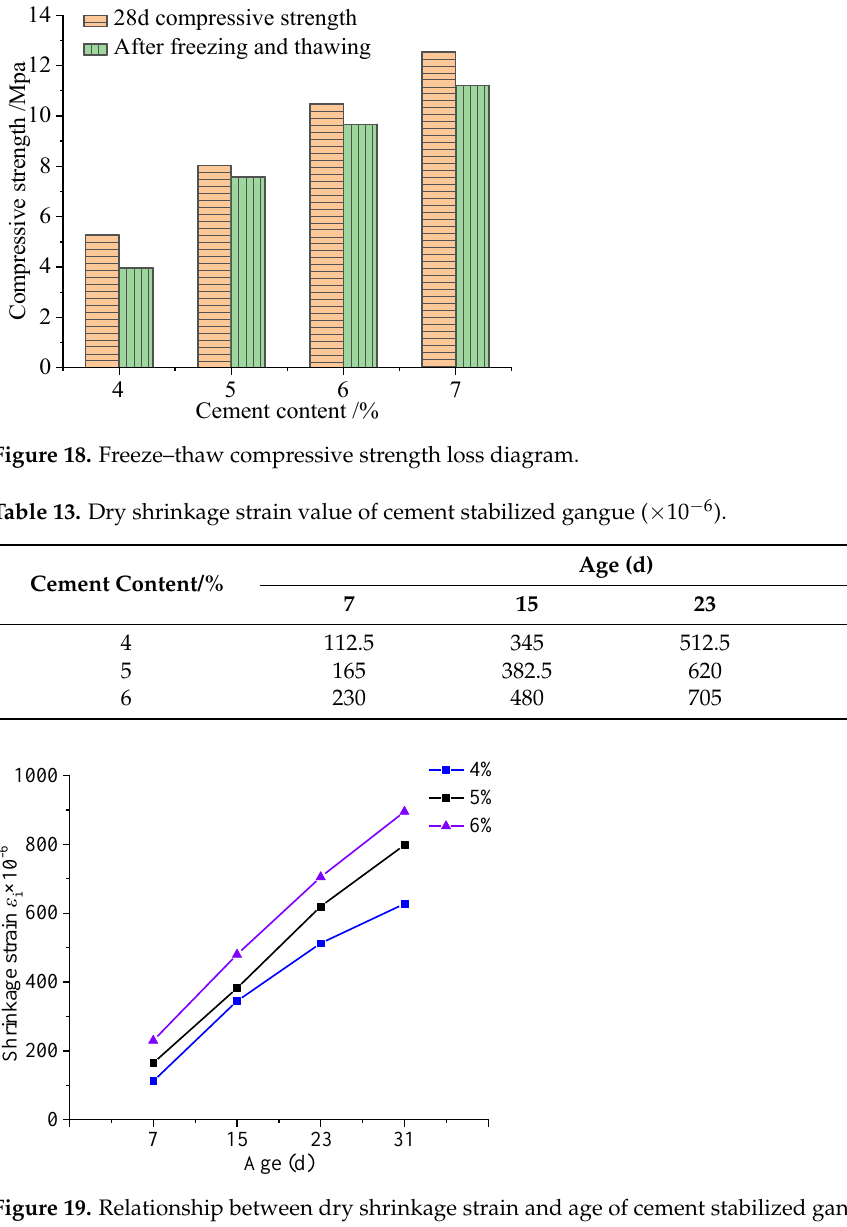
Table 12. Frost resistance index.